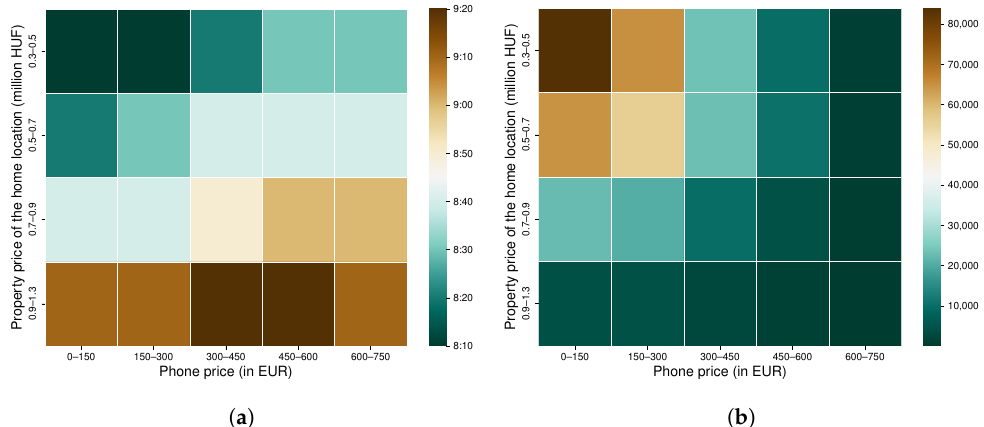
Figure 20. The inhabitant-based wake-up times in the socioeconomic categories, based on the property price of the home location and mobile phone price ( a ), and the number of the subscribers in each category ( b ).